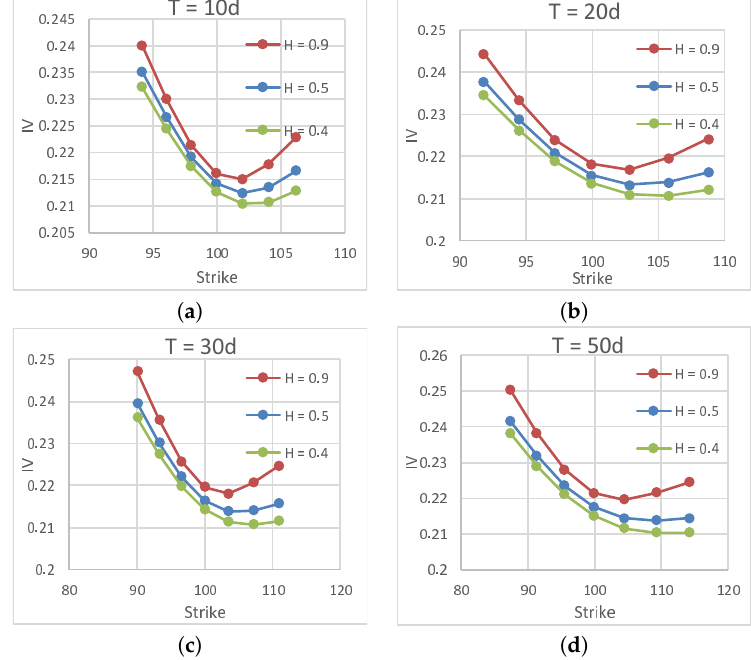
Figure 4. Volatility smile with respect to strike and maturity. ( a – d ) show the volatility smile of T = 0.04, T = 0.08, T = 0.12, and T = 0.2, respectively. The model parameters are listed in Table